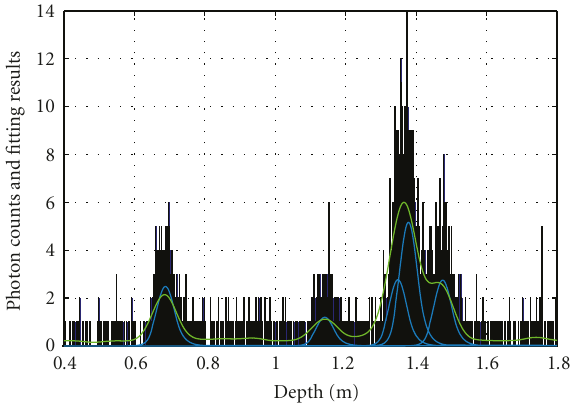
Figure 10: Analysis of TCSPC data from a real target containing 6 distributed surfaces with known separation distances: { 450, 10, 200, 30, and 90 mm } . The blue line gives the 5 peaks detected by RJMCMC method with separations determined to be { 452.4, 207.6, 27, and 100.2 mm } . The green line is the cross-correlation of the signal (for the sake of display clarity, the maximum value is scaled to be 6), which gives 4 peaks with separations { 454.8, 225.6, and 97.8mm }